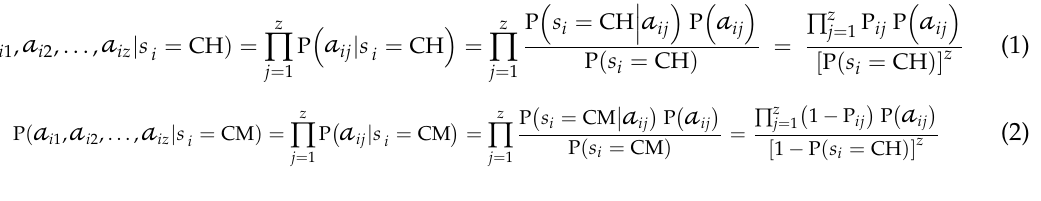
Figure 4. Dynamic clustering scheme.